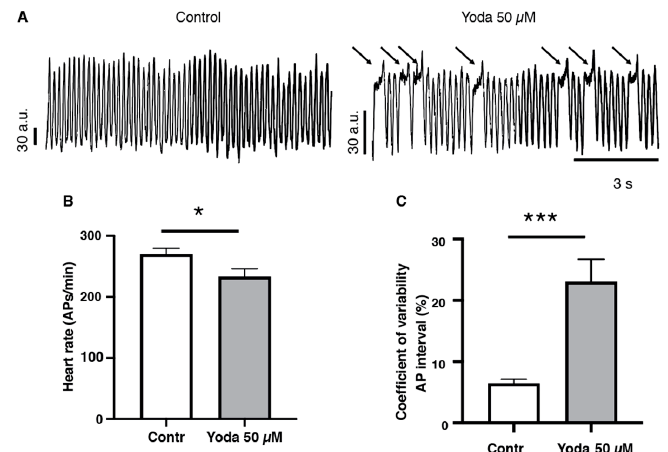
Figure 5. Optical mapping recordings of Yoda1-treated larvae. ( A ) Traces of optical action potentials recorded in the ventricular region of the larvae’s hearts, in control (DMSO) or after prolonged ex- posure to Yoda (50 µM). Arrows indicated prolonged ventricular depolarization. ( B) Heart rate (ven- exposure to Yoda (50 µ M). Arrows indicated prolonged ventricular depolarization. ( B) Heart rate tricular action potentials per minute) and ( C ) coe ffi cient of variability of the action potential interval in control (DMSO) and after prolonged exposure to Yoda 50 µM (n = 19 and 23, respectively). *: p < 0.05 and ***: p < 0.001 by unpaired t -test. interval in control (DMSO) and after prolonged exposure to Yoda 50 µ M (n = 19 and 23, respectively). *: p < 0.05 and ***: p < 0.001 by unpaired t